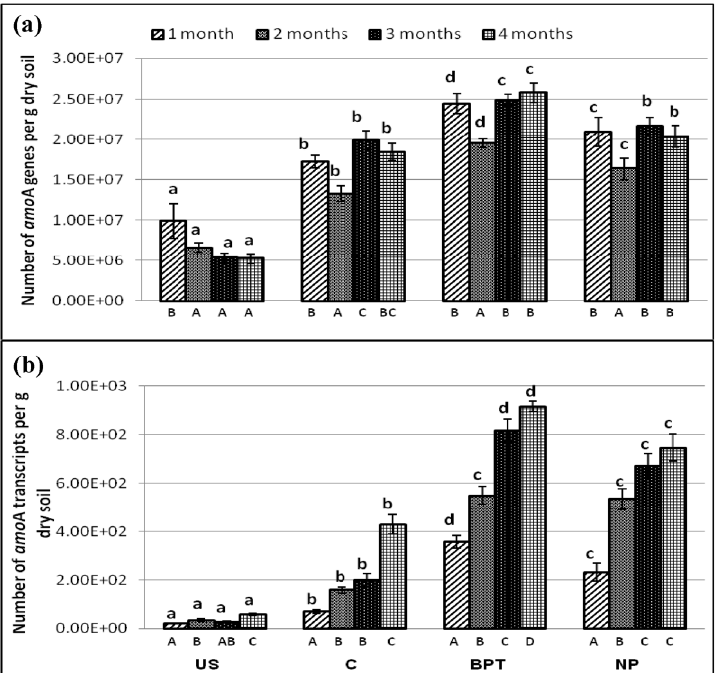
Fig 4. Abundance (copies per g dry soil) of (a) genes (b) transcripts of ammonia-monooxygenase ( amo A) under different treatments at four time points. Error bars represent standard deviations ( n = 3). Significantly different values (p < 0.05) between different sampling time points in the same treatment are marked by capital letters (A to D) under the columns, and between different treatments for the same time point are marked by lower case letters (a to